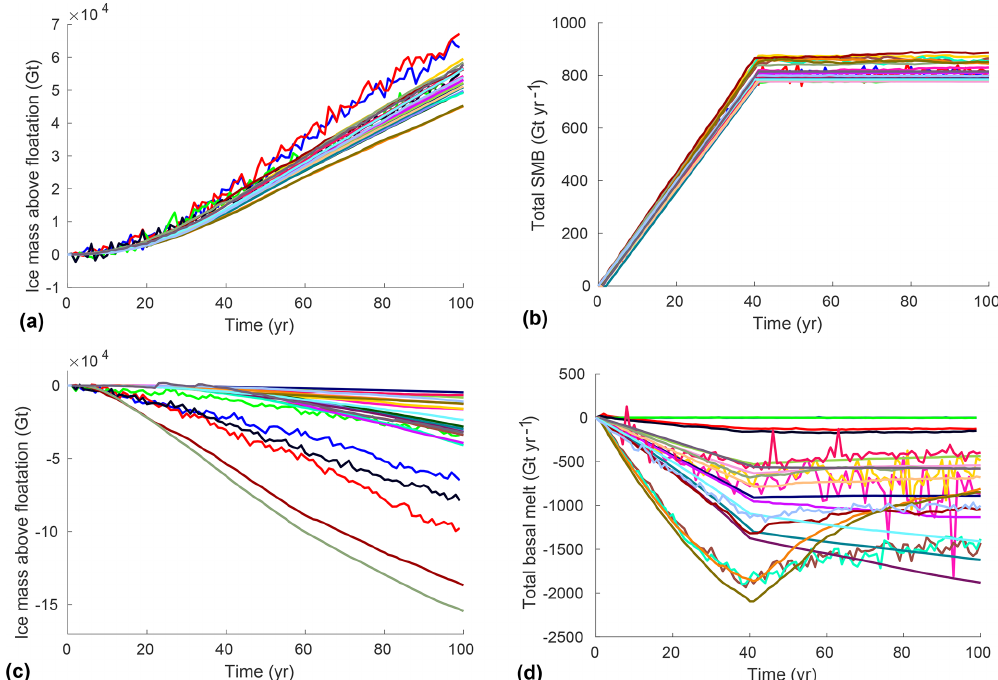
Figure 7. Evolution of the Antarctic ice sheet and external forcings in the asmb ( a and b ) and abmb ( c and d ) experiments compared to the ctrl experiment. Total amount of ice above floatation for asmb minus ctrl (a) and abmb minus ctrl (c) (in Gt). Evolution of SMB applied at the ice surface for asmb minus ctrl ( b , in Gtyr − 1 ) and total basal melting applied in abmb minus ctrl ( d , in Gtyr − 1